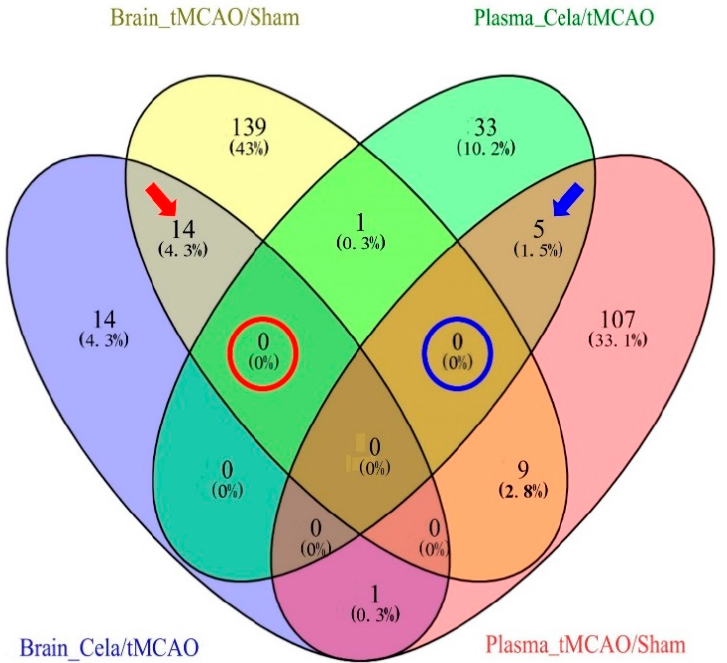
Figure 5. The common and unique differential lipids of different comparison groups.